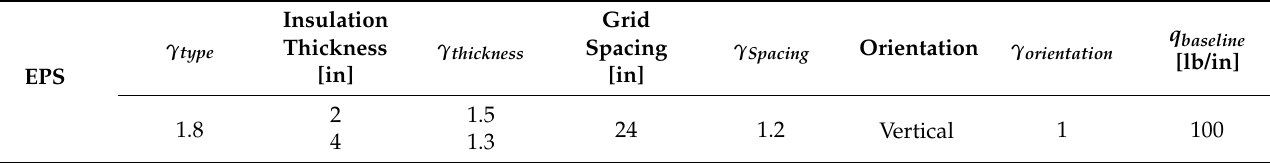
Table 4. Gamma factors determined by Bunn